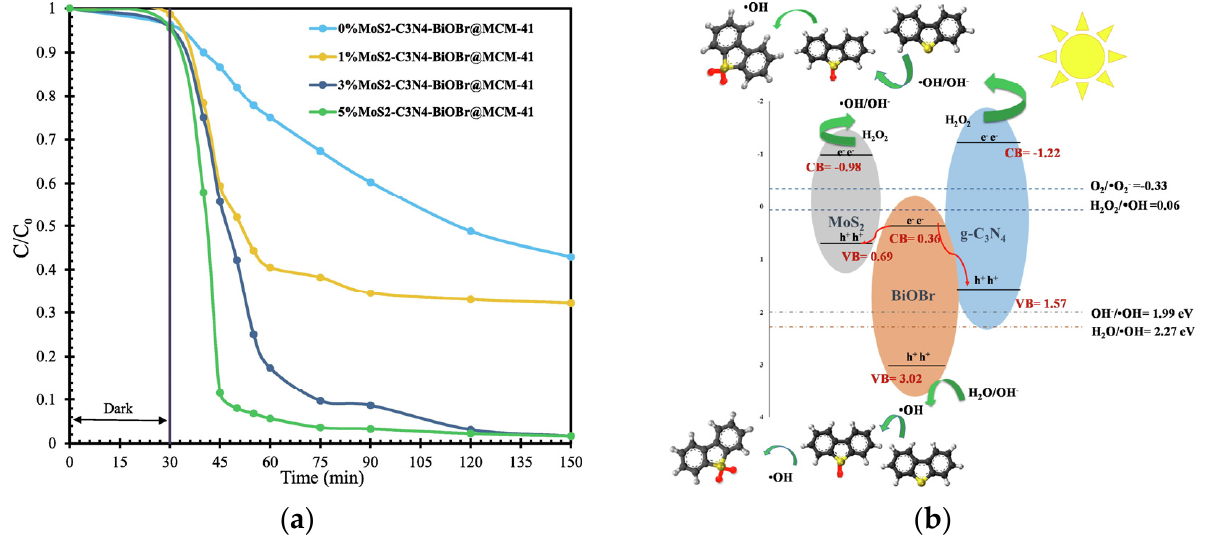
Figure 10. ( a ) Removal of DBT using MoS 2 –g-C 3 N 4 –BiOBr@MCM-41 photocatalysts with different percentages of MoS 2 . ( b ) Mechanism of PODS on the MoS 2 –g-C 3 N 4 –BiOBr@MCM-41 heterojunction photocatalyst. Reproduced from ref. [44] with permission from Elsevier. Copyright 2022